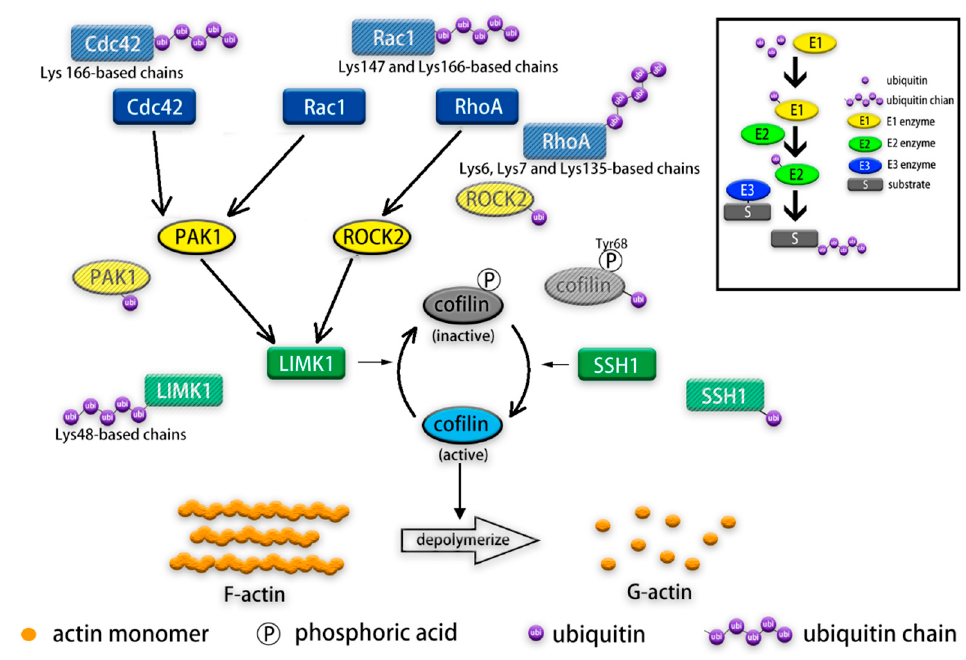
Figure 1. Schematic overview of ubiquitination of actin cytoskeleton regulators. Ubiquitination is a three-step post-transcriptional modification and polyubiquitination of the substrate often leads to its *proteasome-dependent degradation (upper right box). So far, ubiquitination has been found to regulate some actin cytoskeleton regulators, including three well-studied Rho GTPase family members, Rac1, RhoA, and Cdc42, as well as their downstream kinases p21-activated kinase (PAK1) and Rho-associated coiled-coil containing kinase 2 (ROCK2). In addition, cofilin which serves and depolymerizes actin filaments, LIMK1 (cofilin kinase), and SSH1 (cofilin phosphatase) are also regulated by